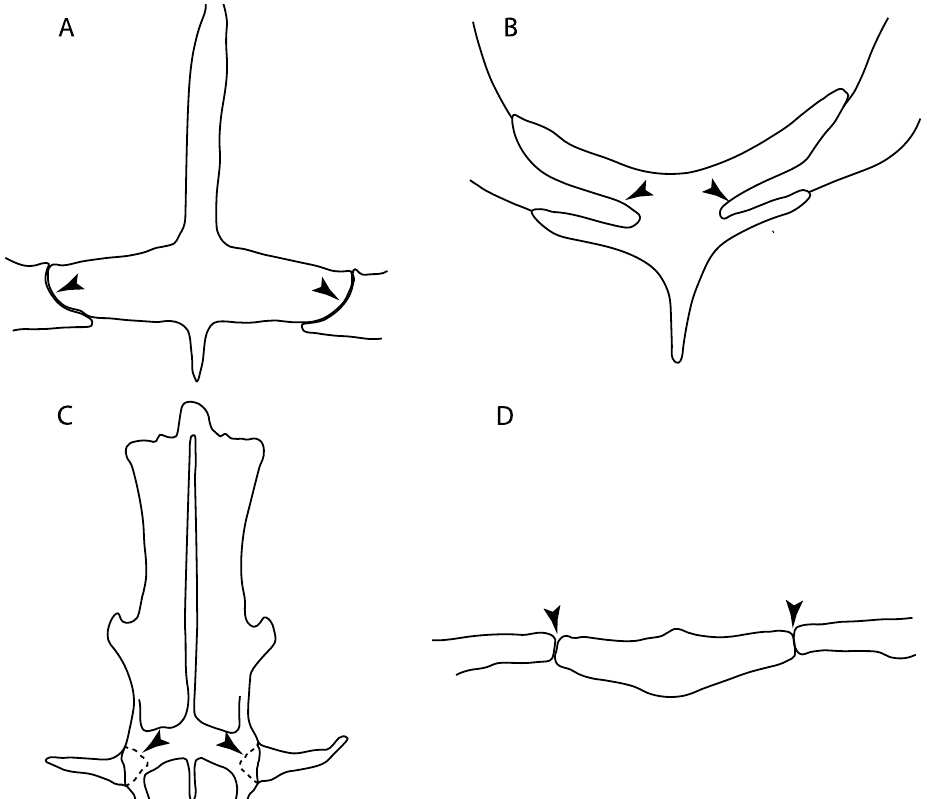
Figure 32. Interpretative drawing of synarcual and suprascapula in dorsal view. State (0) ( A ) Raja clavata (NHMUK 1963.5.14.34-36). State (1): ( B ) Pseudobatos percellens . (UERJ 1240). State (2): ( C ) Urolophus aurantiacus (AMNH 258305, https://sharksrays.org/ (accessed on 23 March 2020)). State (3): ( D ) Torpedo sp. (NHMUK 72261). Arrowheads: articulation between scapula and suprascapula. 97. Crenated suprascapula (variations): (0) With lateral projections; (1) thin upper and lower lobes; (2) upper lobe wider than lower; (3) of similar size and width (new). This